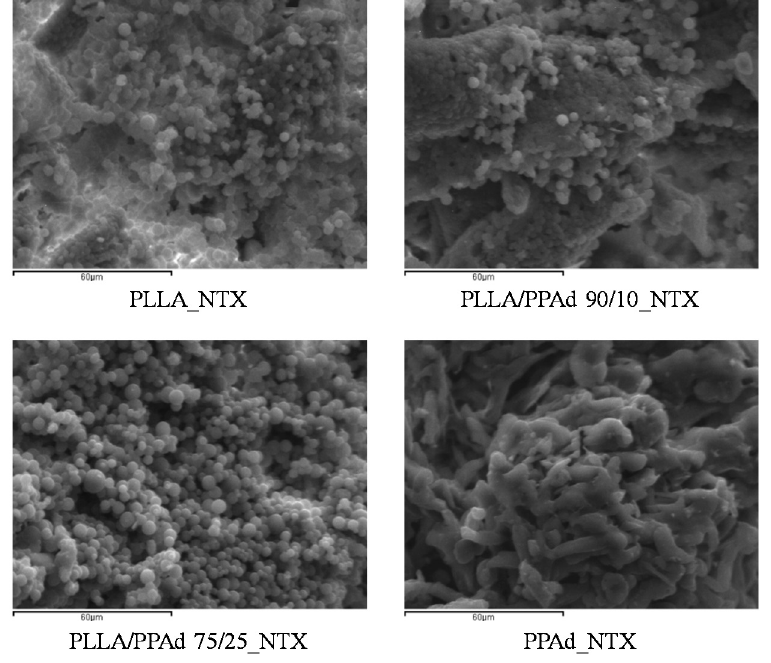
Figure 15. SEM images of NTX-loaded microspheres after 8 days of dissolution.